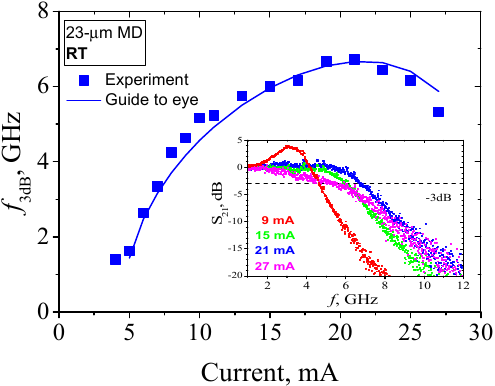
Figure 19. Dependence of 3-dB bandwidth ( f 3dB ) on injection current. Inset: examples of small signal modulation responses at different bias currents. The line is a guide to the eye.